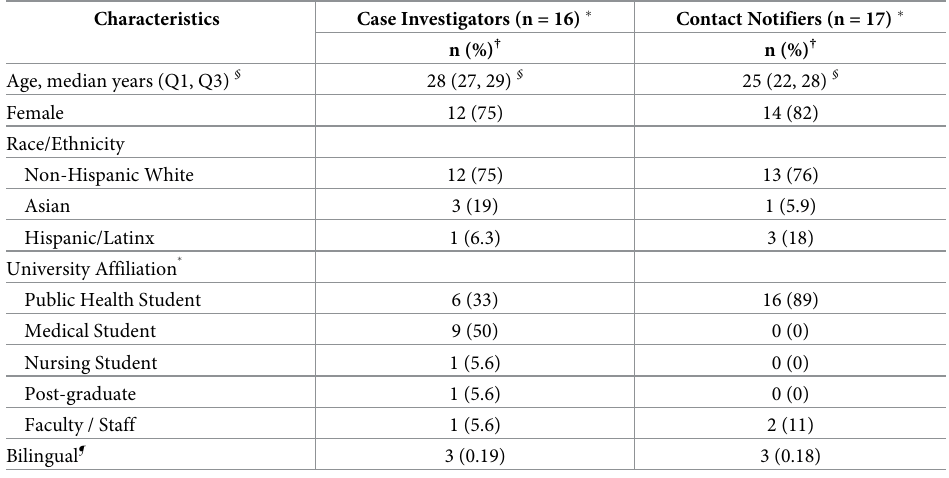
Table 1. Participant